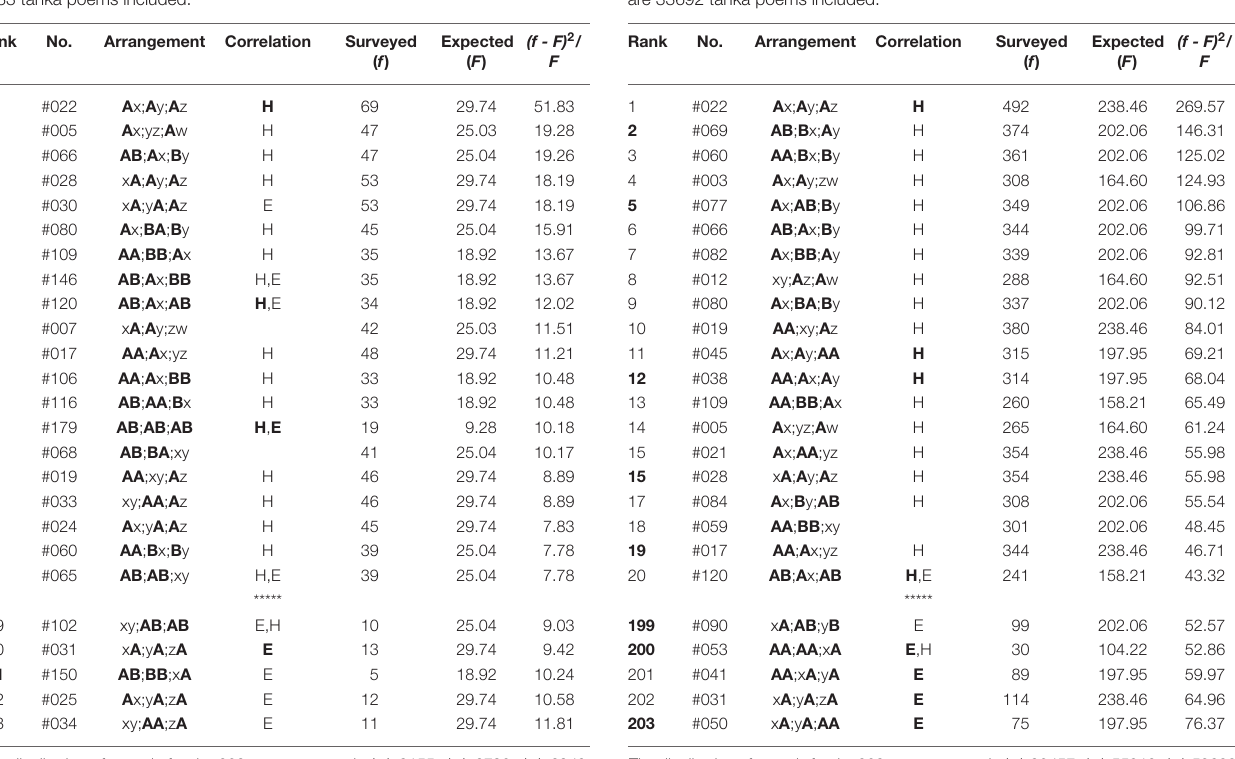
TABLE 9 | The top-twenty and the bottom-five arrangements in the first three phrases (5-7-5) of poems in The Twenty-One Collections of Waka , wherein there are 33692 tanka poems